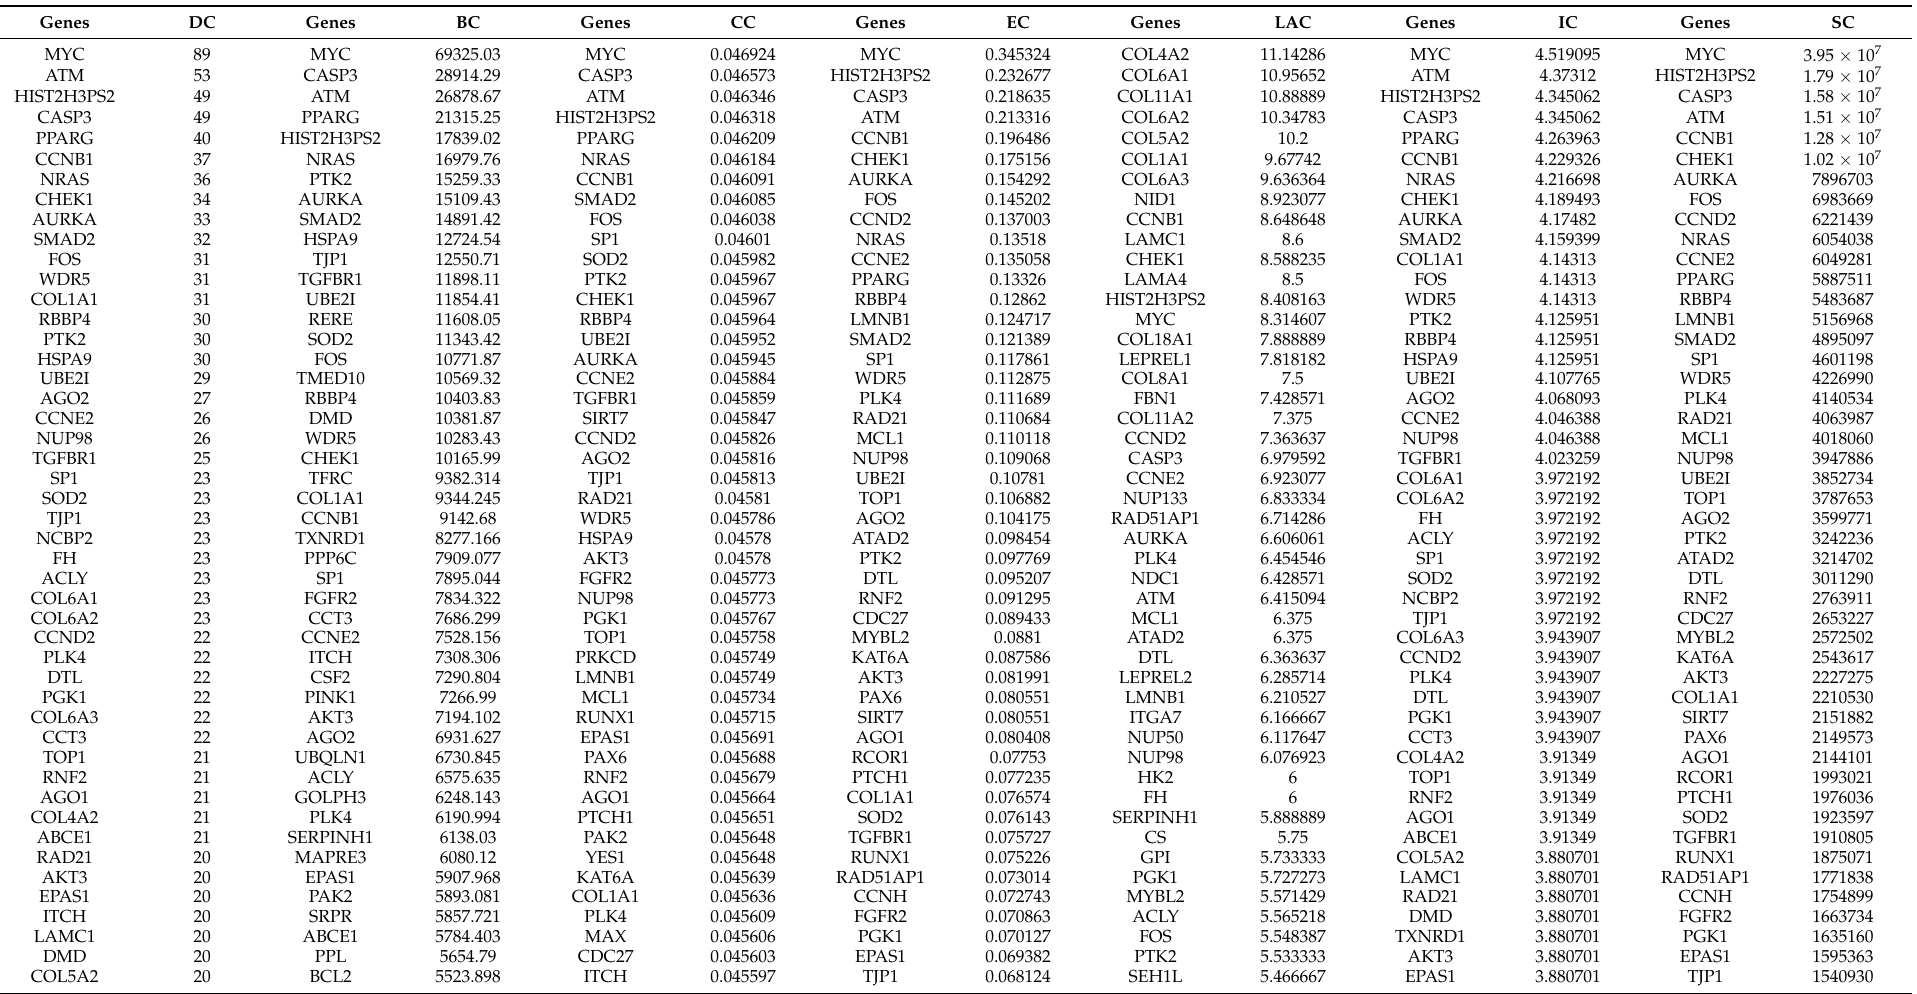
Table 2. Topological characteristics of target genes regulated by lncRNAs in the PPI